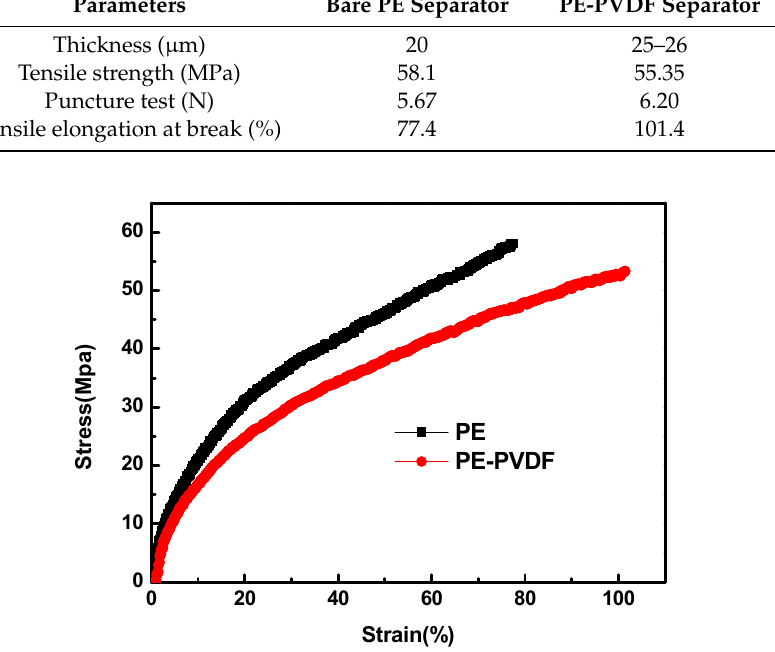
Figure 3. The stress-strain curves of bare PE and PE-PVDF separators. Table 2. Thickness, tensile strength, puncture test and elongation data of separator samples.